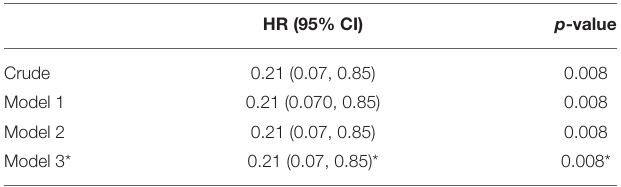
* The fully adjusted result, which is used in interpreting the association between Home- Based Exercise and Incidence of Clinical events. Model 1: after adjustment for age and gender. Model 2: after further adjustment for history of previous myocardial infarction, history of diabetes mellitus, number of stents implanted, whether has residual stenosis or not. Model 3: after further adjustment for BMI, WHR, history of Hypertension, history of smoking,historyofexercise,maximalMETs,oxygenuptakeatAT,VE/VCO 2 , 1 VO 2 / 1 WR, use of at least one antiplatelet drug, use of statins, use of trimetazidine, use of β -blockade, WhetherreceivedemergencyPCIornot,systolicbloodpressurevalueanddiastolicblood pressure value at the baseline